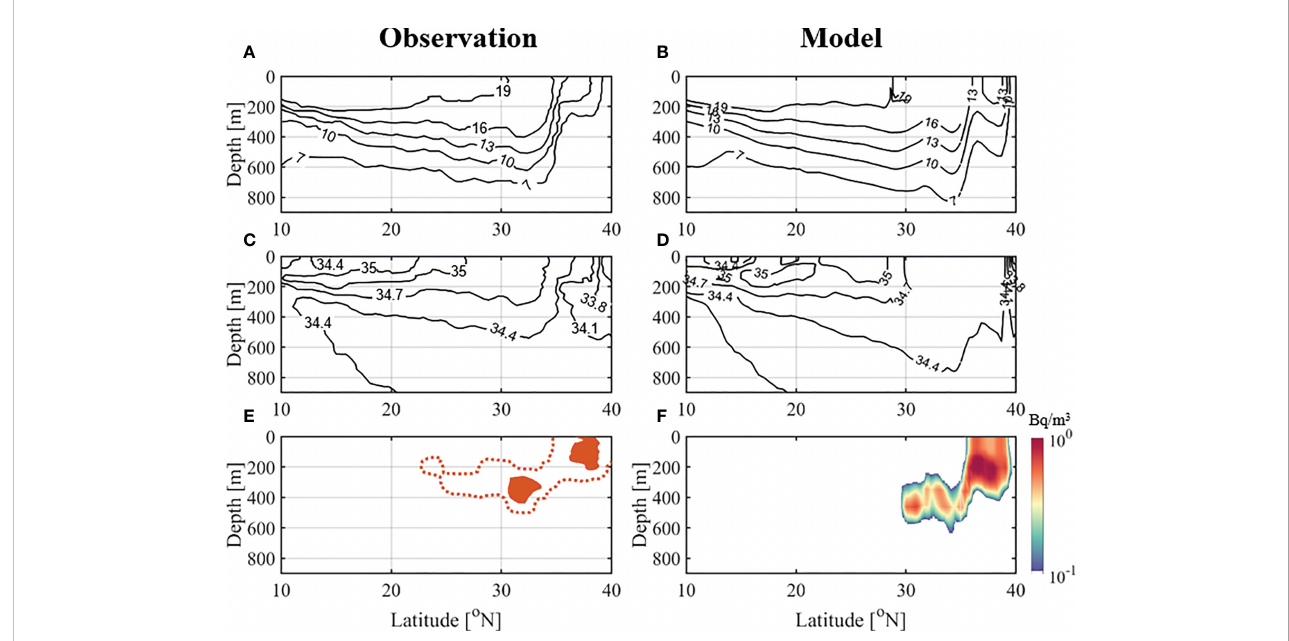
FIGURE 5 Vertical section of (A, B) temperature, (C, D) salinity, and (E, F) 134 Cs in observation (Kumamoto et al., 2014) and model along line L1(149°E). The background contour units are (A, B) the water temperature (°C) and (C, D) the salinity (g/kg). The orange dashed lines denote 2 Bq/m 3 ; orange shadow in the observation denotes ≥ 10 Bq/m 3 . (E) is redraw from Kumamoto et al. 2014, (Figure 3A).